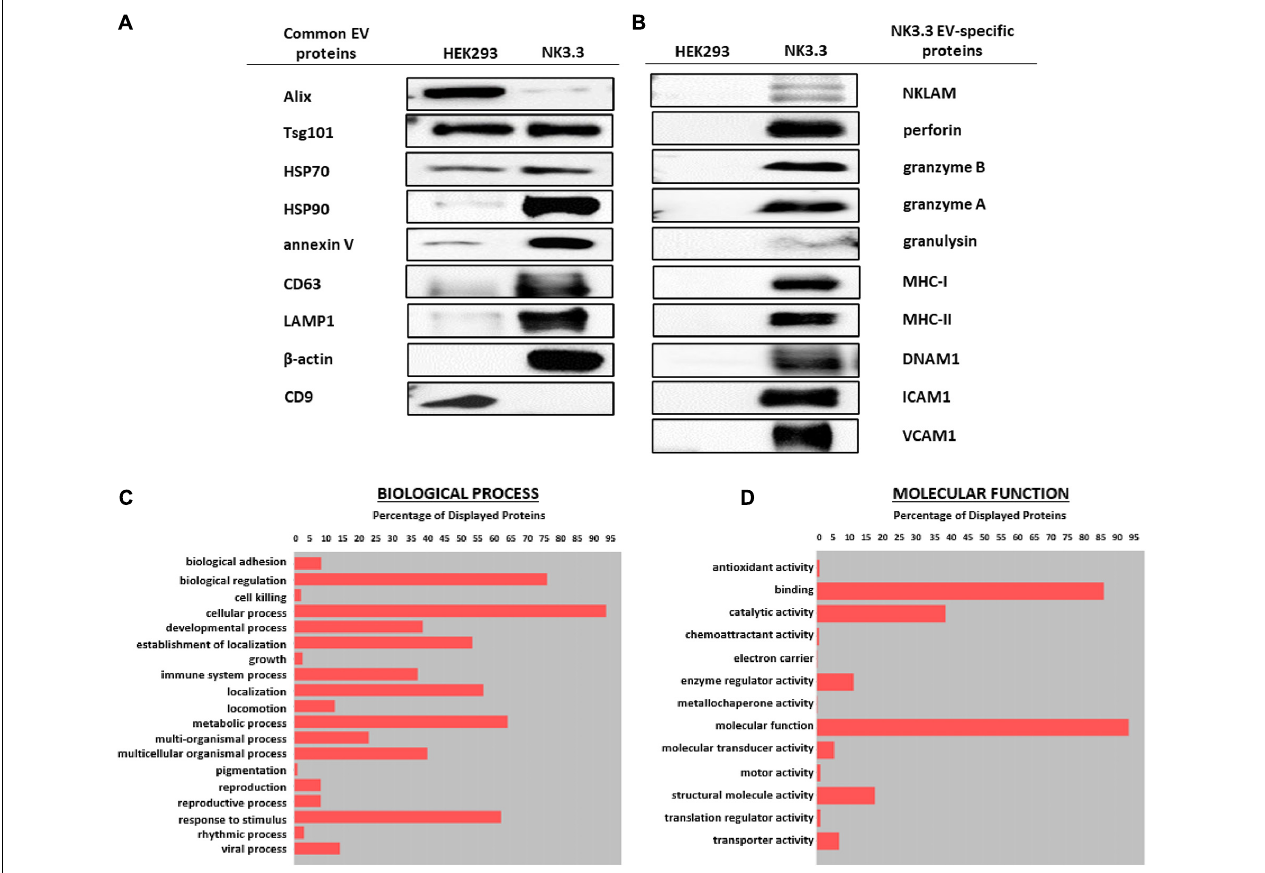
FIGURE 2 | Comparison of EV proteins derived from NK3.3 and HEK293 cells. EV lysates were examined by immunoblot analysis using 30 µ g of EV protein for (A) common EV proteins and (B) proteins specific to NK3.3 EVs. Gene ontology annotation generated from proteomic analysis identified the frequency of (C) biological processes and (D) molecular function associated with the proteins in NK3.3 EVs.